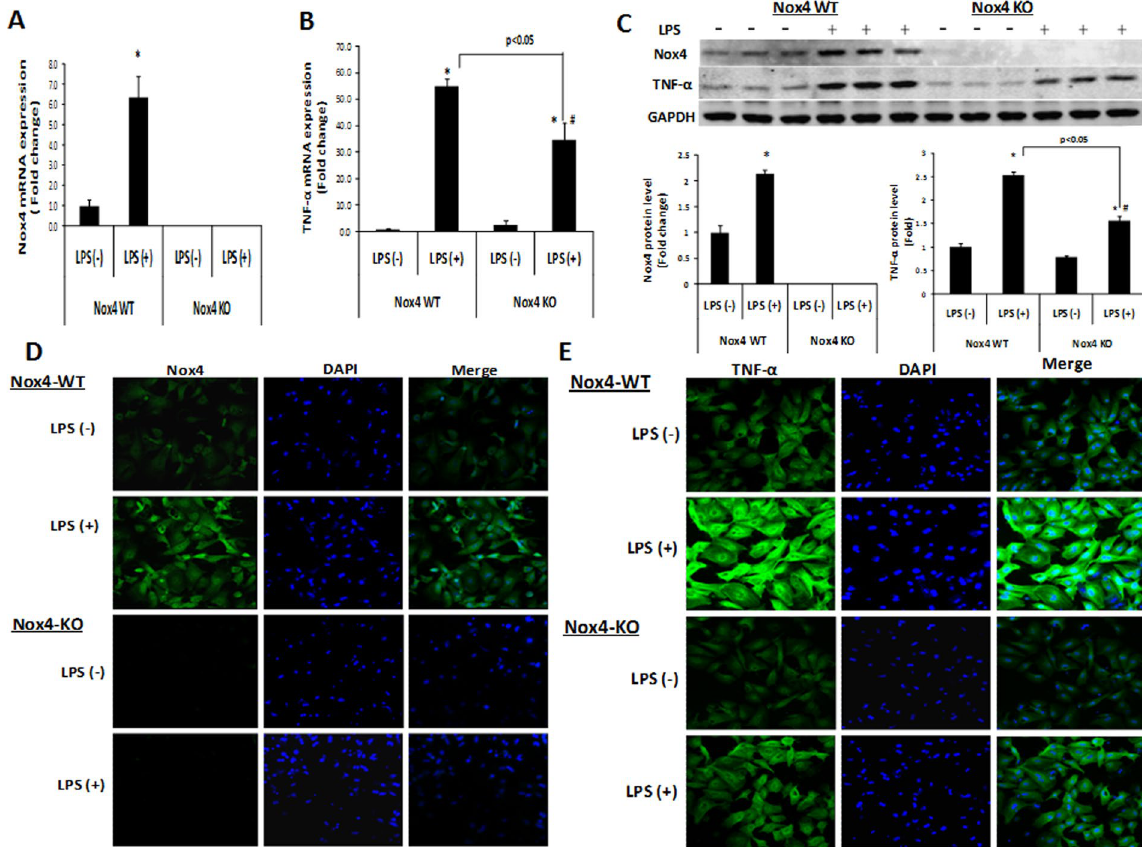
Figure 4. LPS induced TNF- α levels attenuated in primary hepatocytes of Nox4 KO mice. Primary hepatocytes isolated from Nox4 WT (n = 3) and Nox4 KO (n = 3) mice were either treated with PBS or LPS (1 µ g/ml) for 3 hrs, and Nox4 ( A ) and TNF- α ( B ) mRNA expression were analyzed by qRT-PCR. ( C ) Nox4 and TNF- α protein levels were analyzed by western blotting. Densitometry analysis of Nox4 and TNF- α protein levels normalized with GAPDH in primary hepatocytes (n = 3) of each group are shown. ( D , E ) Primary hepatocytes isolated from Nox4 WT and Nox4 KO mice were either treated with PBS or LPS (1 µ g/ml) for 3 hrs were analyzed for the cellular Nox4 ( D ) and TNF- α ( E ) protein levels by confocal microscopy. Confocal microscopic fields are shown ( D , E ), a representative picture of three independent experiments. * indicates statistically significant difference from the corresponding controls (p < 0.05). # indicates statistically significant difference from Nox4 WT LPS ( − ) (p < 0.05). Lines with p values also indicate statistically significance (p < 0.05) between the